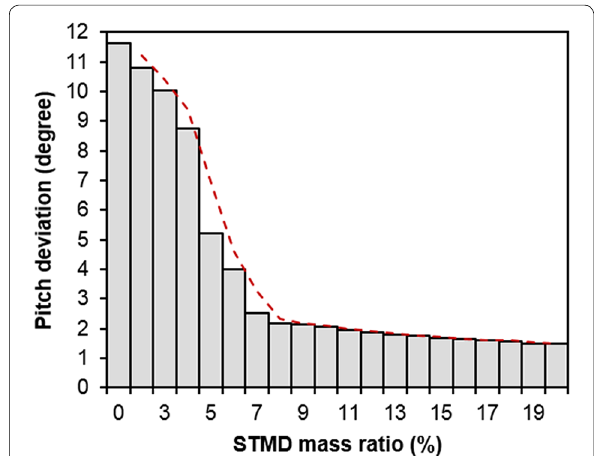
Fig. 15 Passive mode response of the buoy at different mass ratios of 2% to 20% . A standard deviation of the buoy’s pitch deviation with the STMD with mass ratios of 2% to 20% in a passive mode control is presented